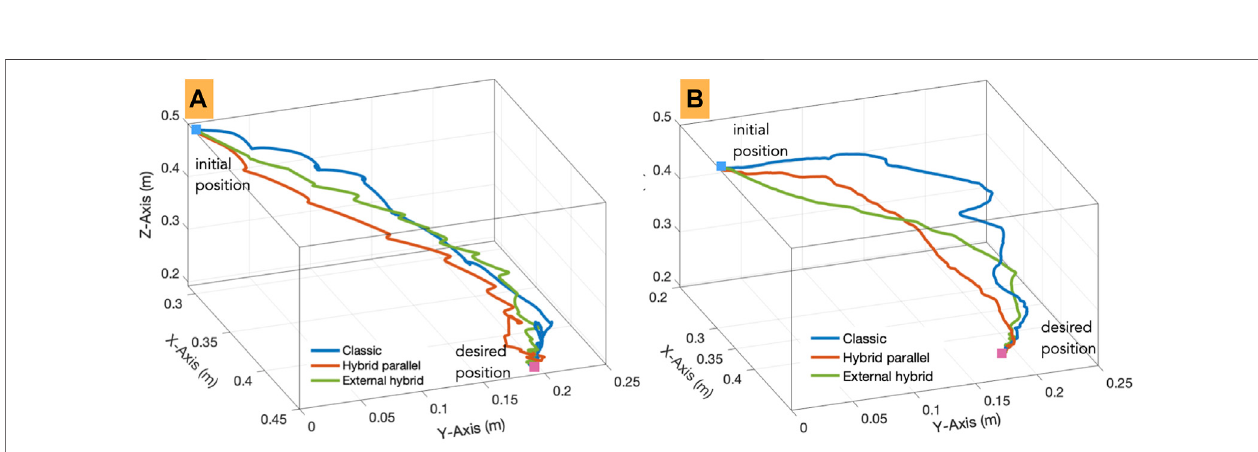
FIGURE 9 | 3D trajectories carried out by an operator using the implemented (A) tele-operation and (B) comanipulation modes.